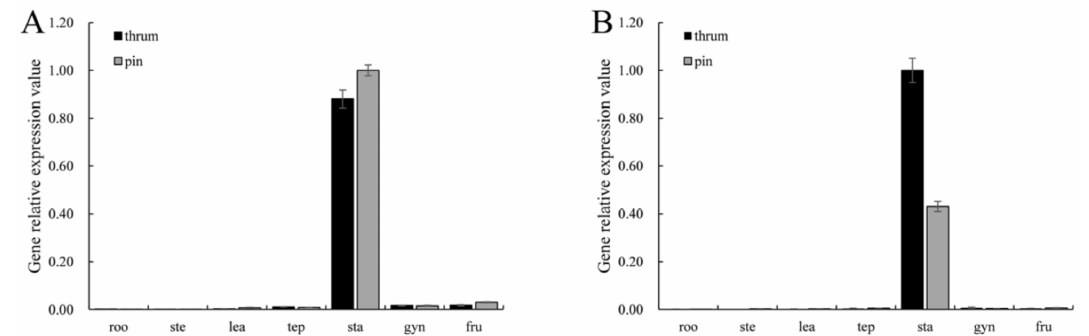
Figure 5. FaesAP3_2 and FaesAP3_2a expression in the roots (roo), stems (ste), juvenile leaves (lea), tepals (tep), stamens (sta), gynoecia (gyn) and 4-day-old fruits (fru) of F. esculentum by qRT-PCR with Faesactin as the internal control. ( A ) FaesAP3_2 expression in different tissues of pin and thrum flower plants were detected by qRT-PCR, respectively; ( B ) FaesAP3_2a expression in different tissues of pin and thrum flower plants were detected by qRT-PCR, respectively.